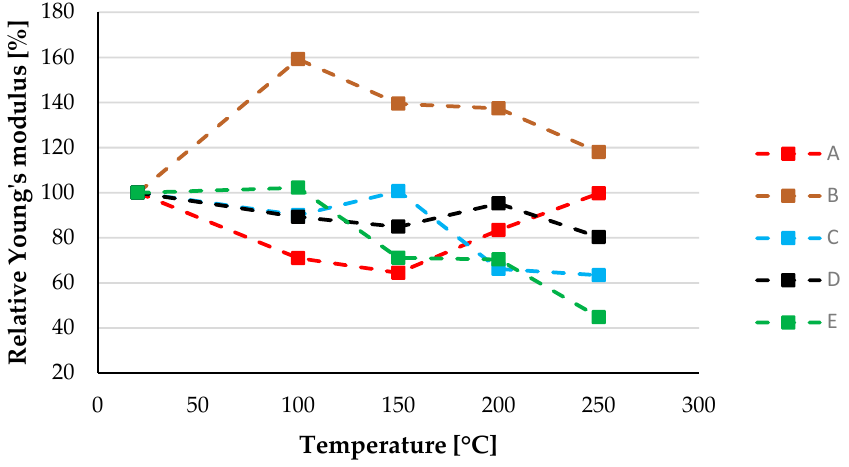
Figure 5. Young’s modulus (%) vs. exposure temperature.